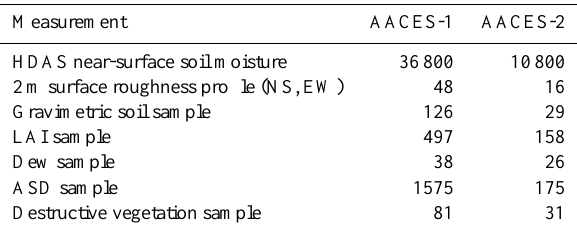
Table 3. Overview of total ground data collected during the AACES field